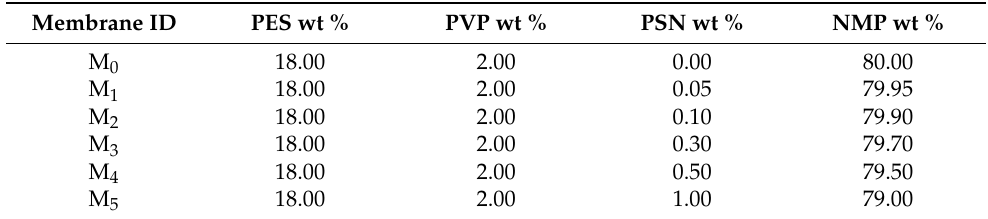
Table 1. Casting solution